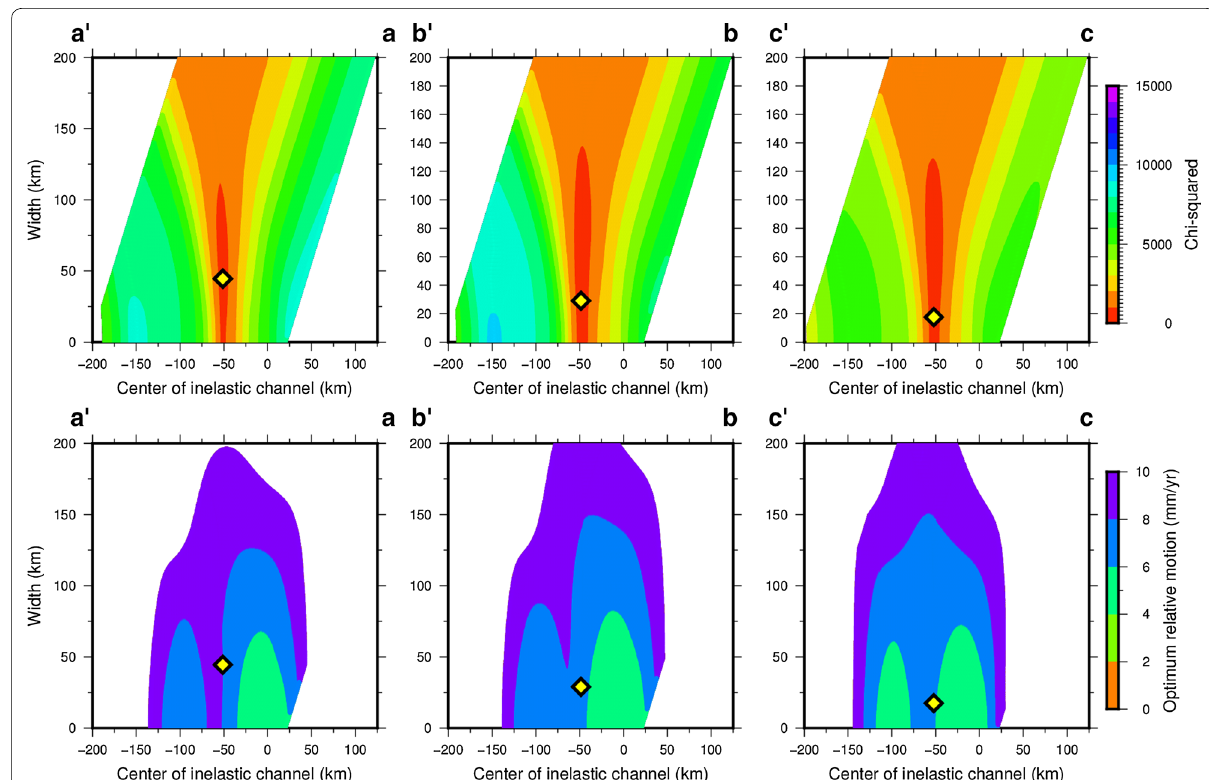
Fig. 3 Distribution of Chi‑squared residuals and optimum relative motion values at 13 km depth. a Chi‑squared residuals (top) and optimum relative motion (bottom) with respect to the width and horizontal location of the inelastic channel in Eastern Tottori ( a ), Central Tottori ( b ) and Western Tottori ( c ). Bottom panels show possible relative motion less than or equal to 10 mm/year